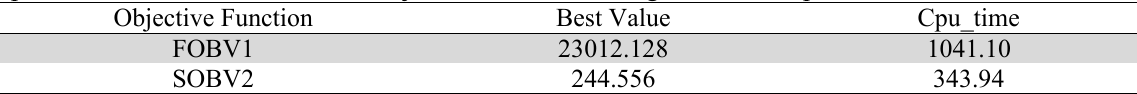
Objective Function